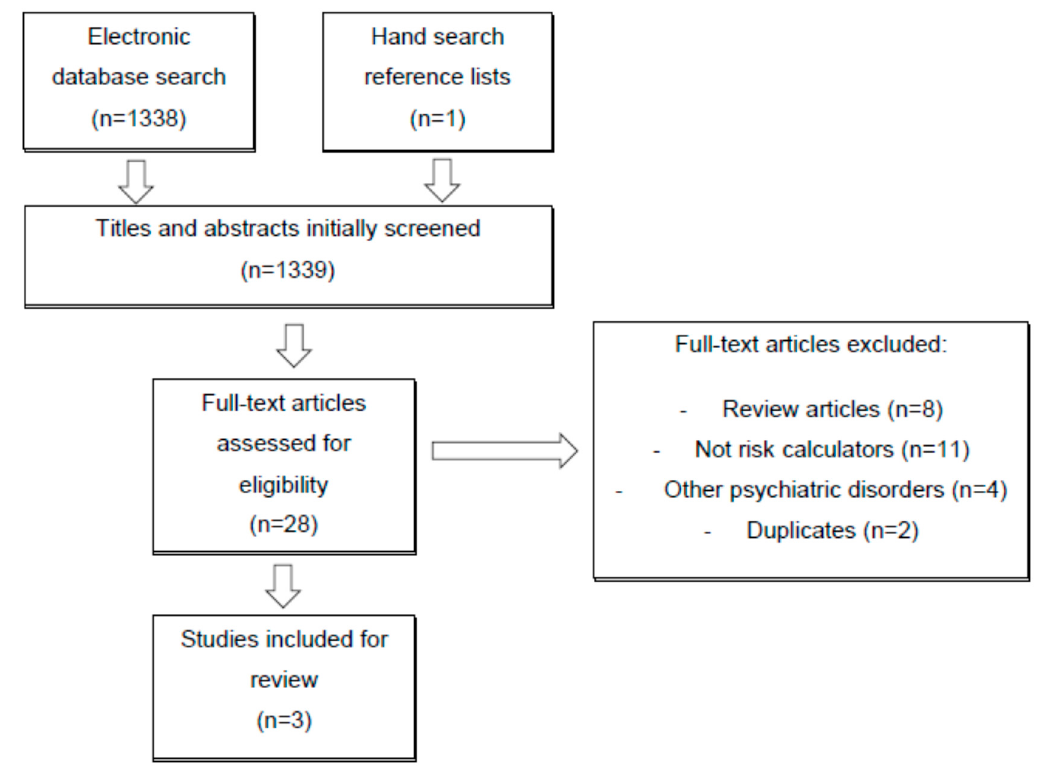
Figure 1. Preferred Reporting Items for Systematic Review and Meta-Analysis (PRISMA) flow diagram of the study selection process